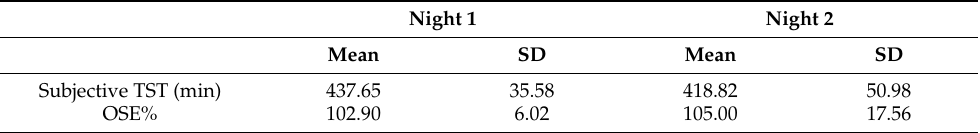
Table 3. Summary of subjective sleep from sleep laboratory study phase ( n =